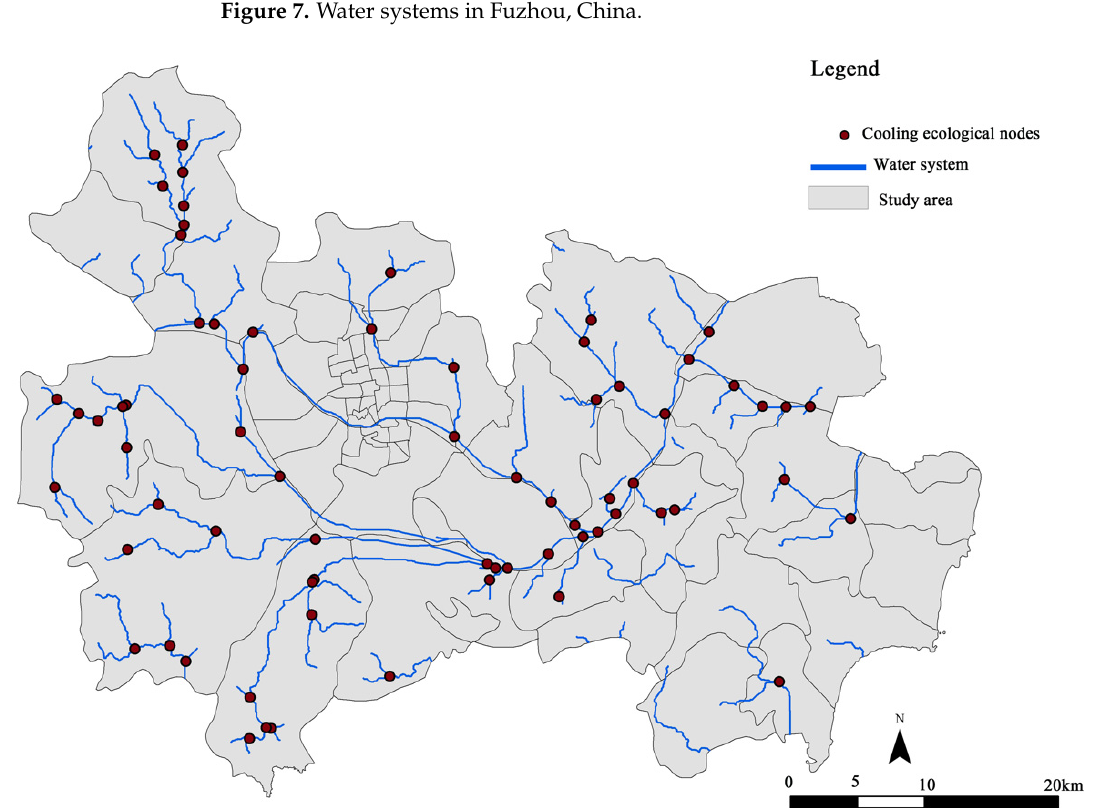
Figure 8. Distribution of the cooling ecological nodes of water